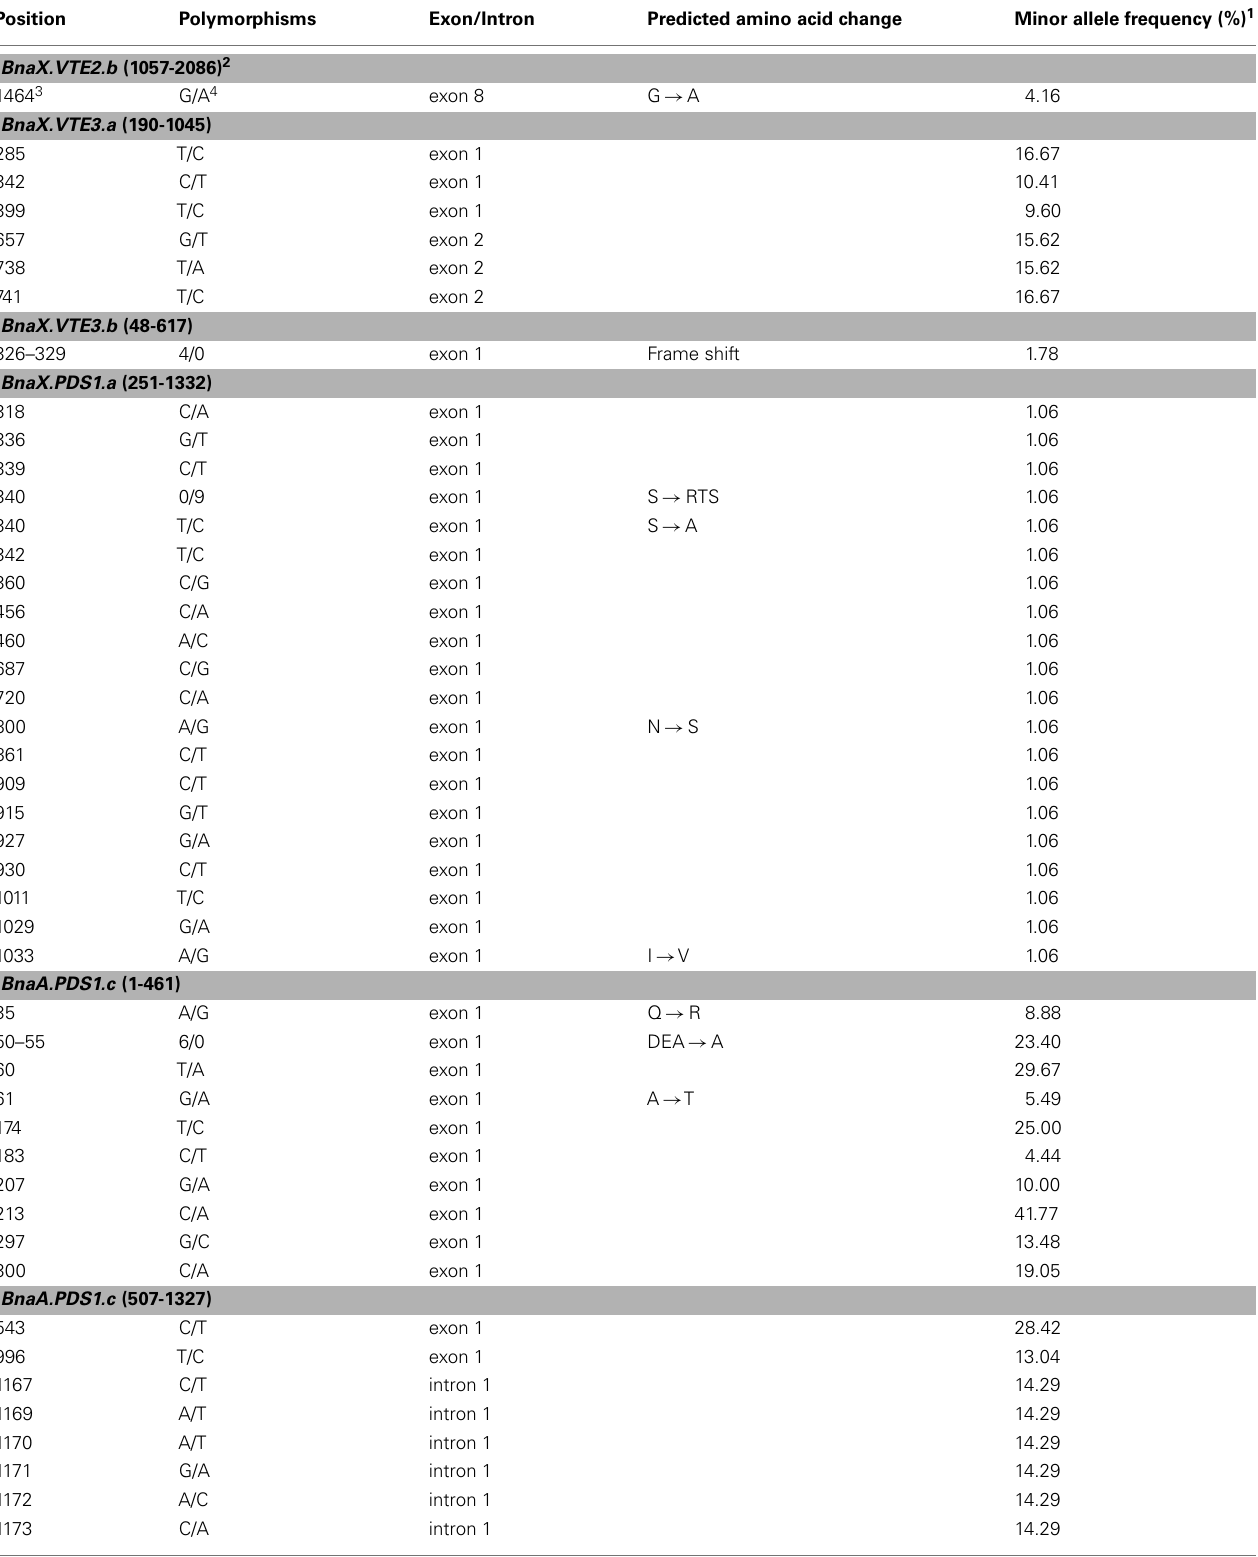
Table 5 | Polymorphic sites within tocopherol candidate genes evaluated in 96 B. napus accessions (panel 1), their position in the gene and exon/intron-position, predicted amino acid change, and minor allele